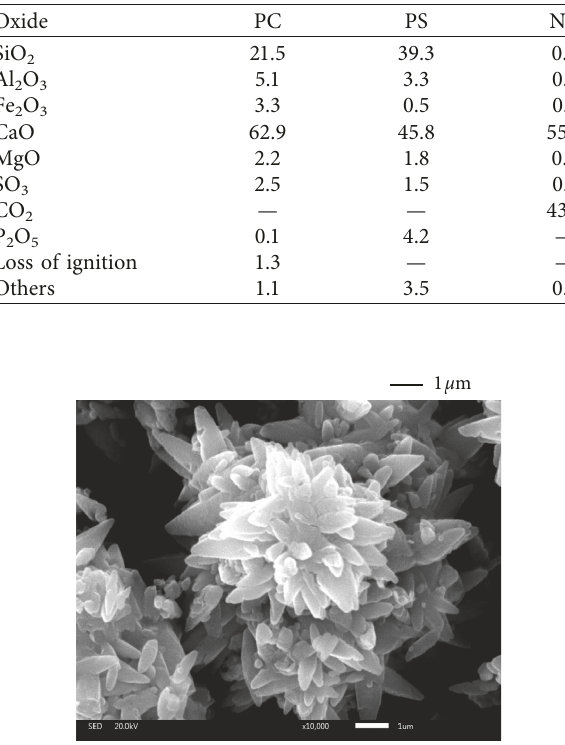
Figure 1: SEM of NC.